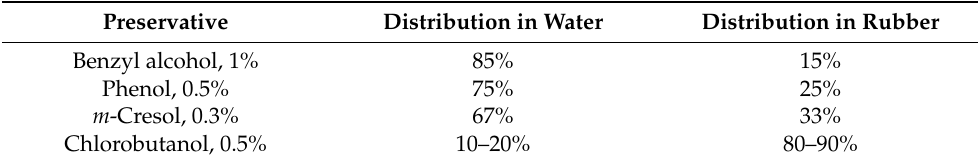
Table 9. Partition of preservatives in water and rubber [118]. Preservative Distribution in